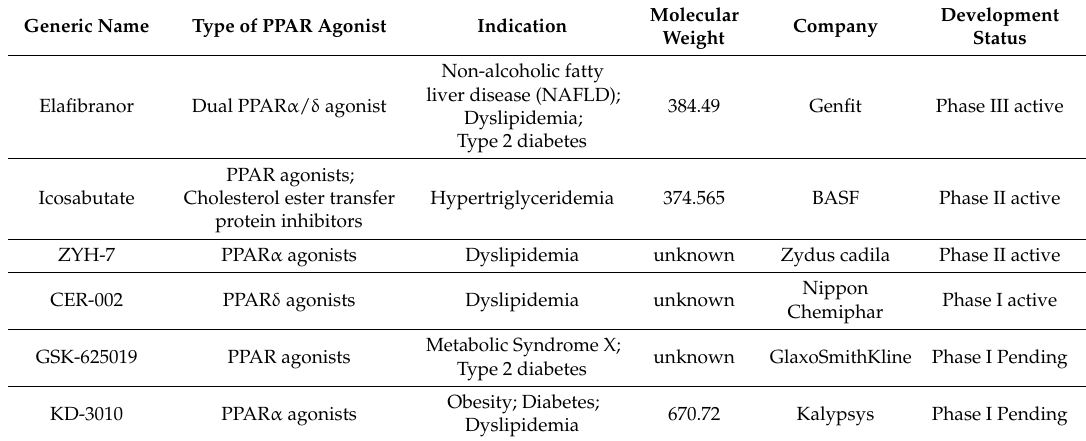
Table 9. Drugs of PPAR ligands for treatment of dyslipidemia in clinical